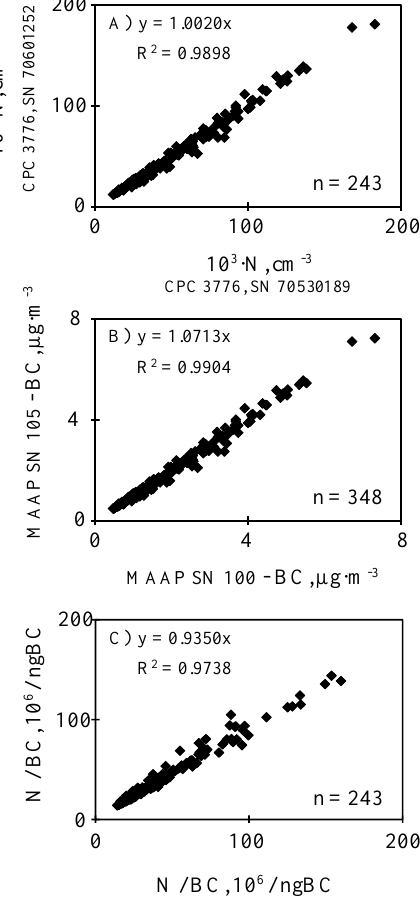
Fig. 2. Inter-comparison between the 10 min averaged data recorded with two CPCs model 3776, two MAAPs and the N/BC ratio recorded with these instruments. Data plotted in Y-axis were collected with the instruments (CPC SN70530189, MAAP SN 105) used in this